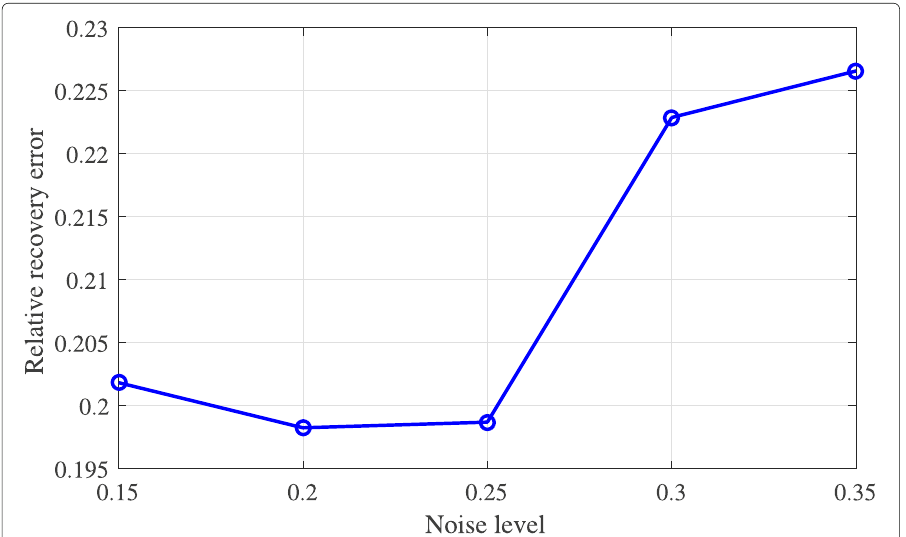
Fig. 10 Relative recovery error when noise level in the recovery process increases (without adding additional noise)